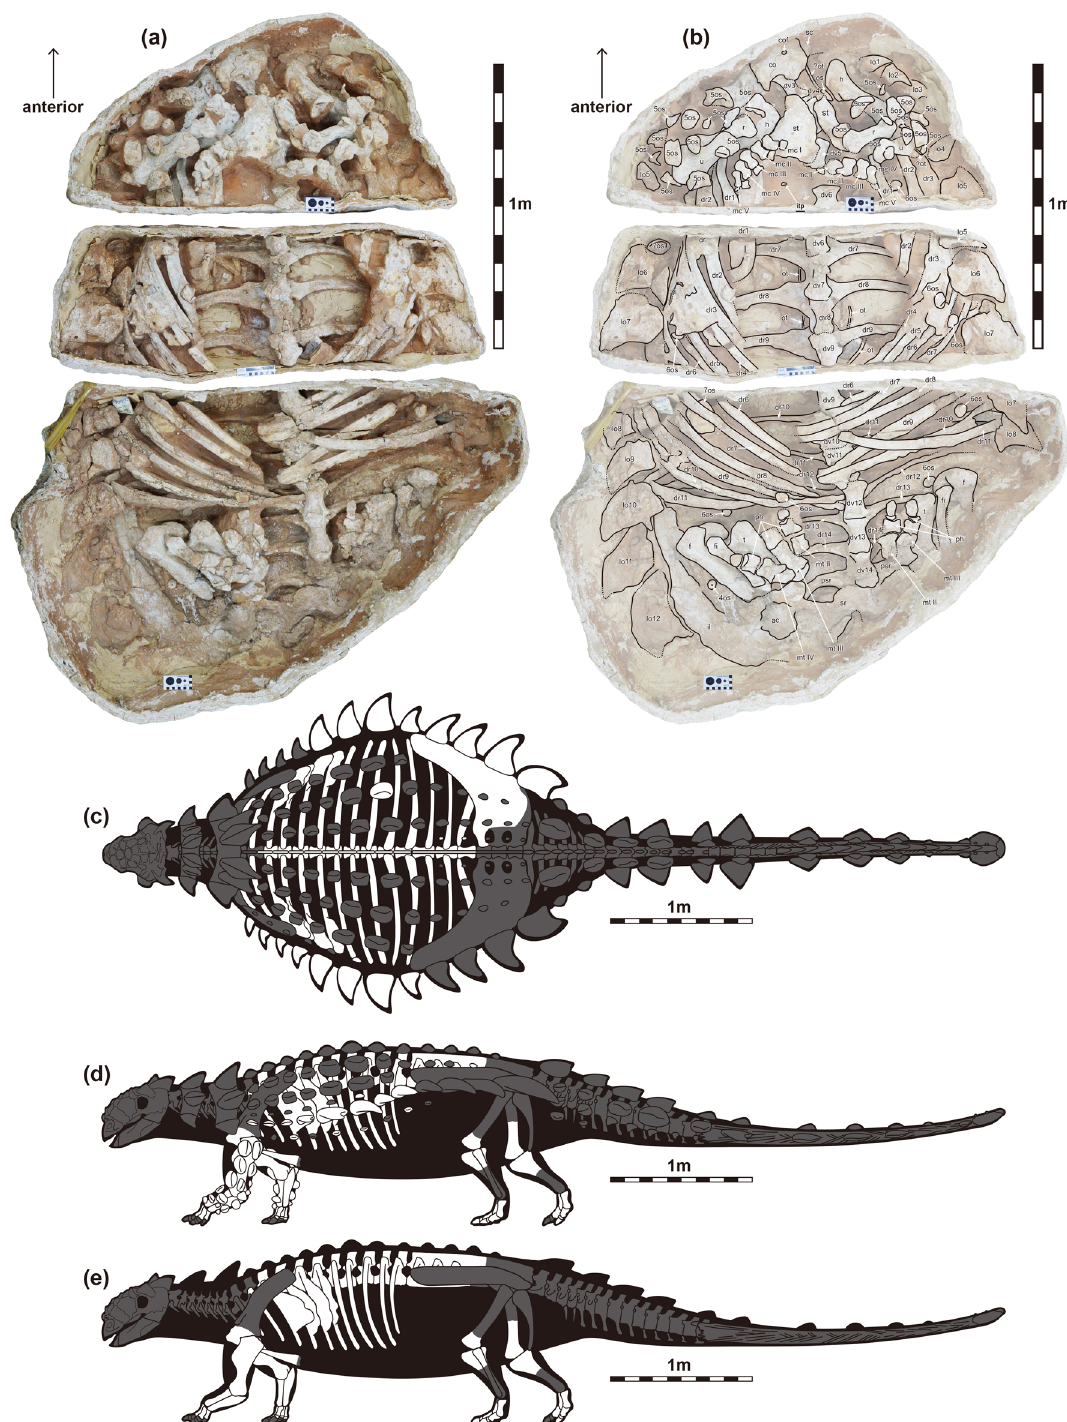
Figure 2. The new ankylosaurid postcranial specimen (MPC-D 100/1359). ( a ) Photograph and ( b ) line drawing of the specimen in ventral view. ( c – e ) Skeletal diagram of the specimen in dorsal view ( c ), left lateral views with dermal armor ( d ) and without dermal armor ( e ). Abbreviations: 4os, Type 4 osteoderm; 5os, Type 5 osteoderm; 6os, Type 6 osteoderm; 7os, Type 7 osteoderm; ac, acetabulum; co, coracoid; cof, coracoid foramen; dr, dorsal rib; dv, dorsal vertebra; f, femur; fi, fibula; h, humerus; il, ilium; itp, isolated theropod phalanx; lo, lateral osteoderm; mc, metacarpal; mt, metatarsal; ot, ossified tendon; psr, parasacral rib; ph, phalanx; r, radius; sc, scapula; sr, sacral rib; st, sternal plate; sv, sacral vertebra; t, tibia; u, ulna. Adobe Illustrator CC (version 24.0.1, https ://www.adobe .com/kr/produ cts/illus trato r.html) was employed to produce ( c – e